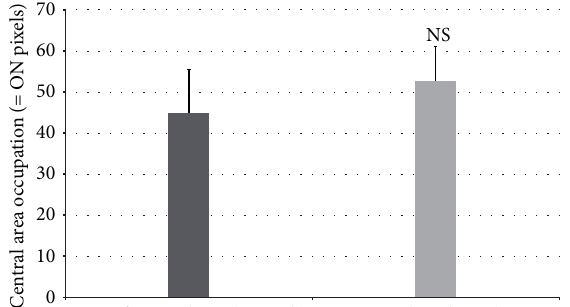
Figure 3: Response of female Megaplatypus mutatus measured as the central area occupation (= on pixels) for 𝛼 -copaene compared to its respective control. Each bar represents the mean of 10 independent replicates ± SE. NS: not significant differences between treatment and control group (Kruskal-Wallis Test, 𝑃 > 0.01 ).